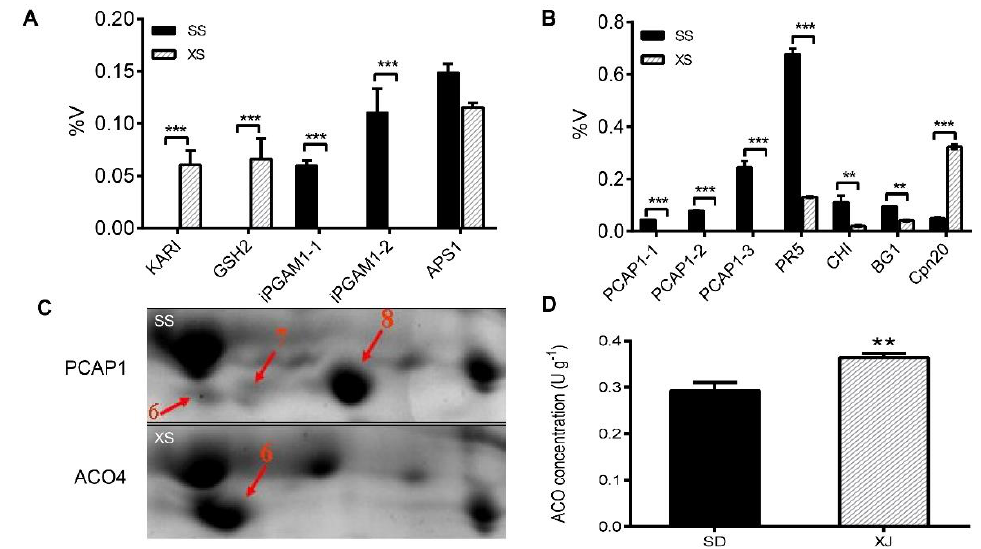
Figure 5. Expression patterns of representative differentially expressed proteins in shoots from two Eutrema ecotypes under normal hydroponic conditions. ( A ) Quantitative analysis of differentially expressed protein (DEPs) species spots related to cellular metabolic processes. ( B ) Quantification of DEPs spots related to stress responses. ( C ) Changes in the expression of the ACO4 protein spot in the shoot. ( D ) ACO concentrations in SD and XJ shoots. Statistical analysis was performed on the normalized volume percentage (% Vol) of protein spots in 3 replicate biological samples using the mean ± SD method and statistical calculations were performed using the t-test. (** p < 0.01 and *** p < 0.001). The abbreviations for Figure 5 were: SS, shoot of SD ecotype; XS, shoot of XJ ecotype; KARI, ketoacid reductase isomerase; GSH2, glutathione synthetase; iPGAM1, 2, 3-bisphosphoglycerate-independent phosphoglycerate mutase 1; iPGAM1 − 1, spot SS4; iPGAM1 − 2, spot SS5; APS1, ATP sulfurylase 1; PCAP1, plasma membrane-associated cation-binding protein 1;